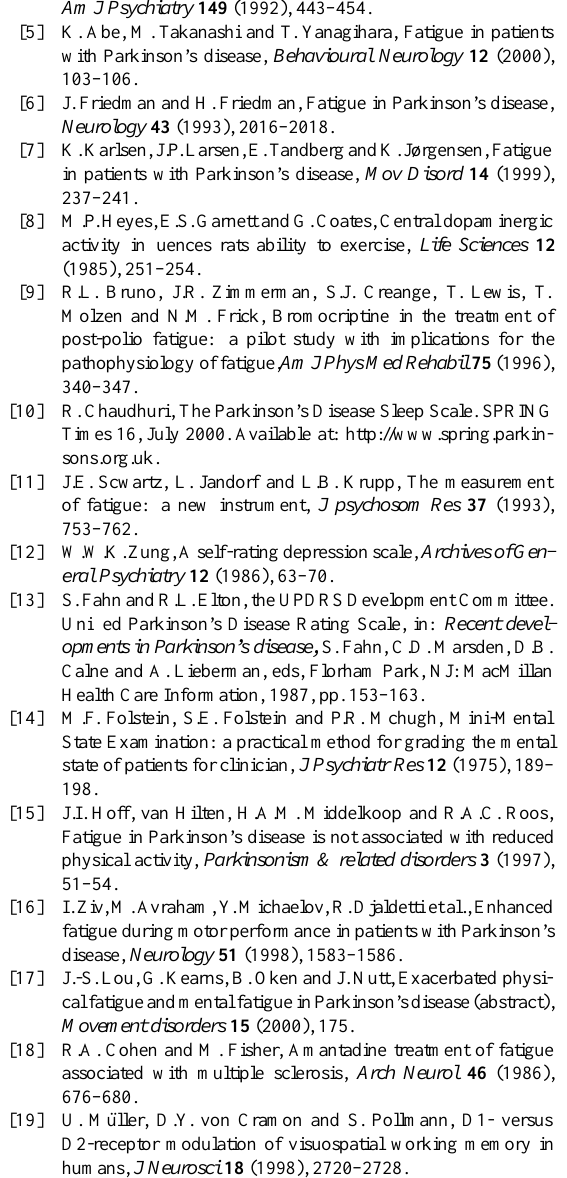
State Examination: a practical method for grading the mental state of patients for clinician, J Psychiatr Res 12 (1975),